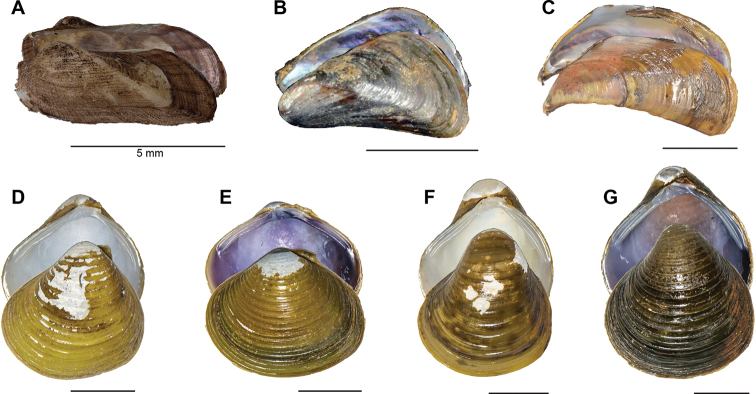
Freshwater bivalves of the Tonle Sap basin, Cambodia (Arcidae, Mytilidae, Cyrenidae) AScaphula
minutaBLimnoperna
fortuneiCSinomytilus
harmandiD–GCorbicula spp. Scale bars: 10 mm, unless stated otherwise. Photographs by TH Ng (A–C) and K Macharoenboon (D–G).